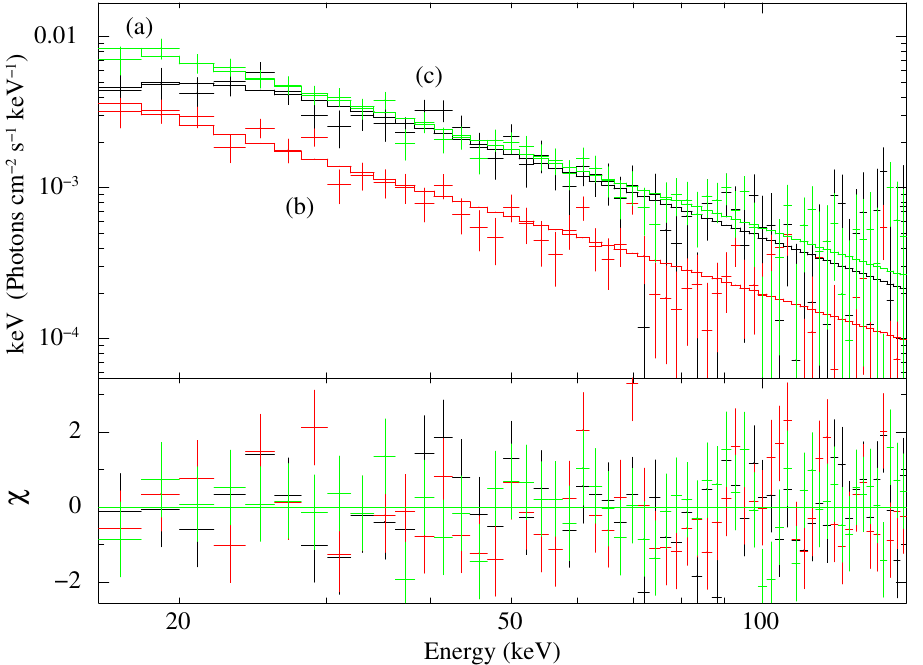
Figure 8. Time resolved BAT spectra for observation on MJD 57,188.77 is shown. The spectra correspond to exposures of ( a ) 220 s, ( b ) 680 s and ( c ) 160 s.